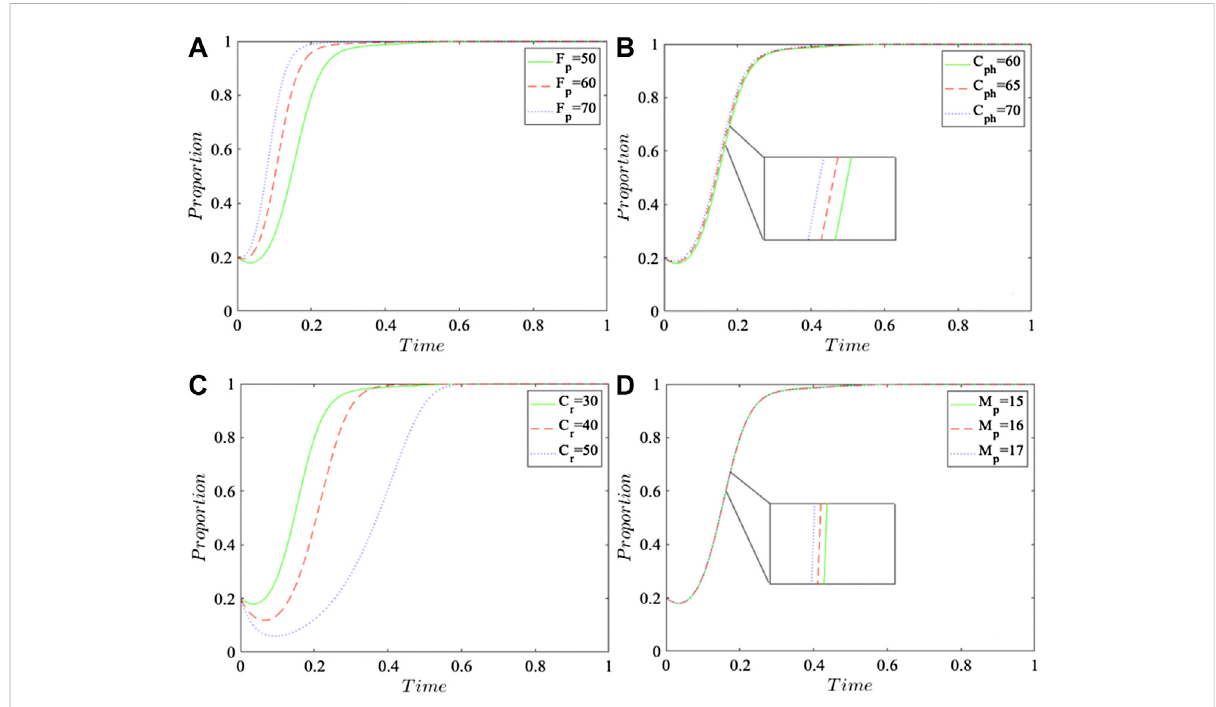
FIGURE 7 In fl uence of changingparameters on power battery manufacturers. (A) Impactof changes in the amount of punishment, (B) impactof changes in pro fi ts from using power batteries, (C) impact of changes in collaboration costs, (D) impact of changes in the amount of